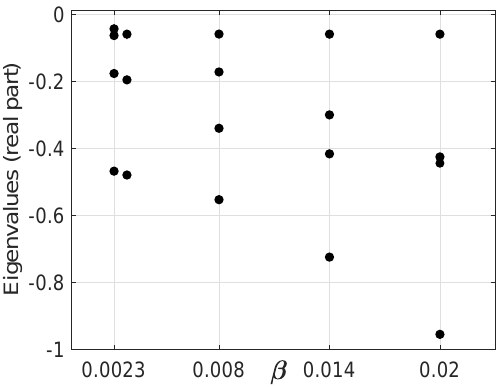
Figure 4. Eigenvalues of the Jacobian matrix evaluated for β = 0.0023, 0.003, 0.008, 0.014,